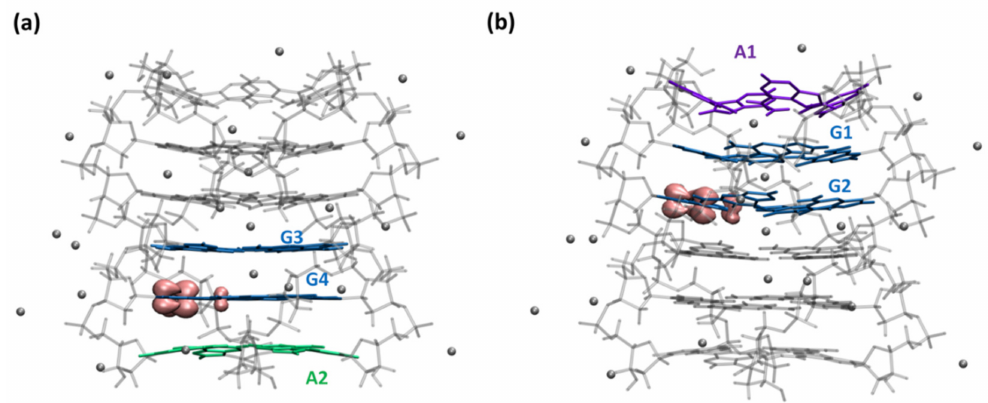
Figure 3. Spin densities for the optimized radical cation in the systems ( a ) (G 4 A) 4 /K + and ( b ) (AG 4 ) 4 /K + . MM guanines, backbone and ions are depicted in gray, QM guanines in blue, adenines in violet (at 5 (cid:48) ) and green (at 3 (cid:48)